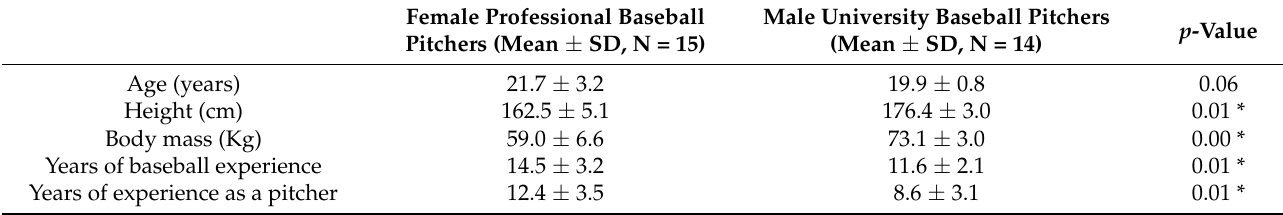
Table 1. Attributes of the